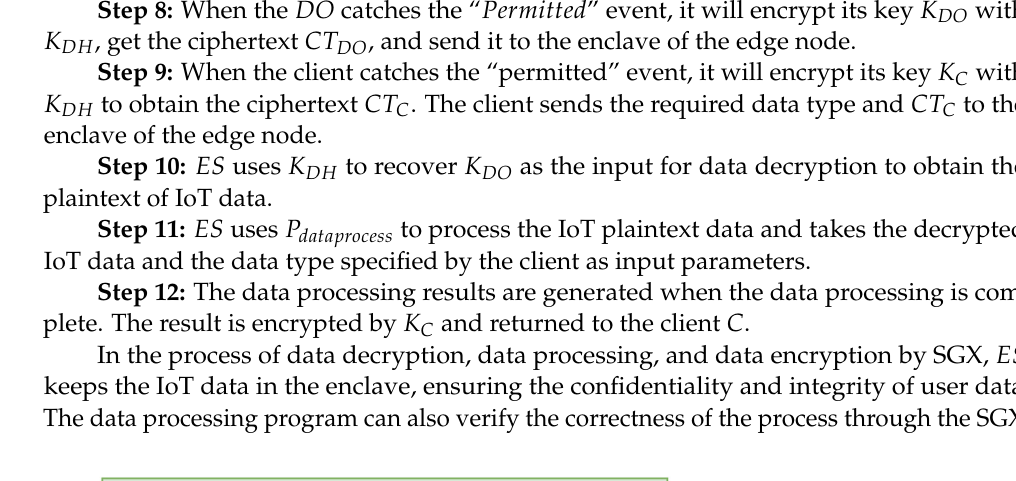
Algorithm 4. Deregistration of Client